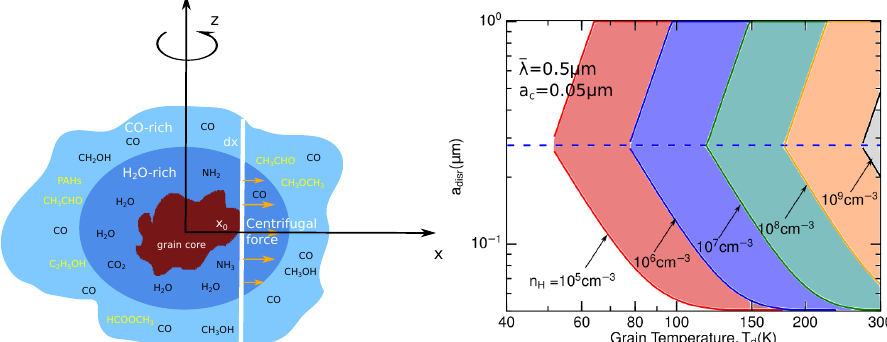
Figure 6. Left panel: Illustration of a rapidly spinning core-mantle grain of irregular shape, comprising an icy water-rich (blue) and CO-rich (light blue) mantle layers. The core is assumed to be compact silicate material, and complex organic molecules are formed in the ice mantle of the core. Centrifugal force field on a slab dx is illustrated, which acts to pull off the ice mantle from the grain core at sufficiently fast rotation. Right panel: Range of desorption sizes of ice mantles, constrained by a disr (lower boundary) and a disr,max (upper boundary), as a function of the grain temperature for the different gas densities for ¯ λ = 0.5 µ m, assuming a fixed core radius a c and the varying mantle thickness. The horizontal dashed line denotes the transition grain size a trans = ¯ λ /1.8. Shaded regions mark the range of grain sizes disrupted by RATD. From Hoang and Tram